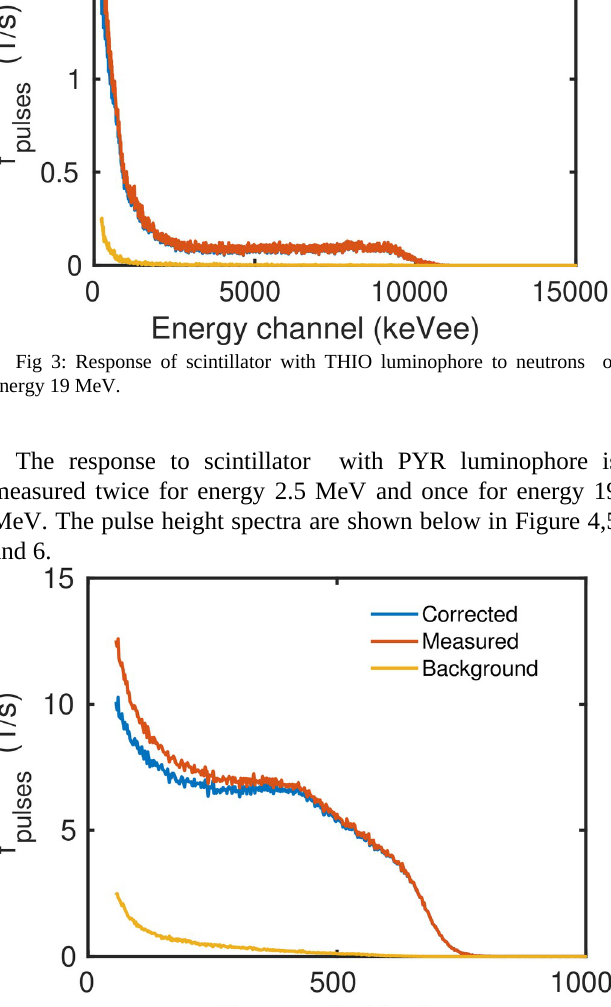
Fig 2: Response of scintillator with THIO luminophore to neutrons of energy 2.5 MeV. Then the response of the scintillator with THIO luminophore to neutrons of energy 2.5 MeV is shown in Figure 2. The measured pulse height spectra is shown with red line. Then the measurement with shadow cone to subtract the scattered background neutrons is shown with yellow line. And finally the corrected pulse height spectrum is shown with blue line.